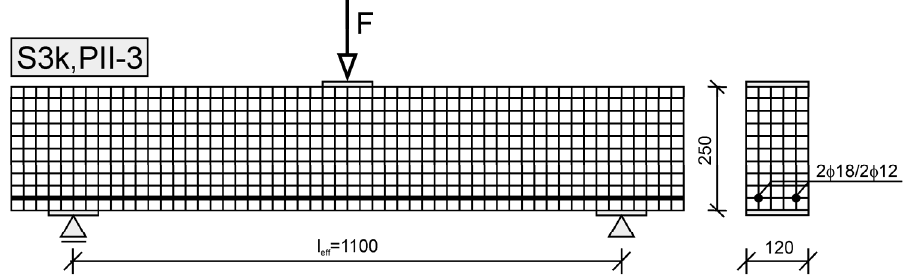
Table 3. Members considered in FEM analysis.